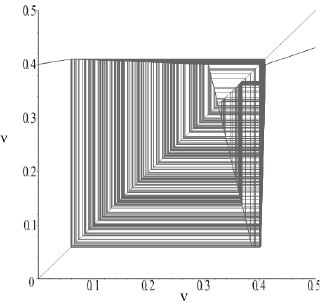
Figure 11. Iterative paths of voltage map.